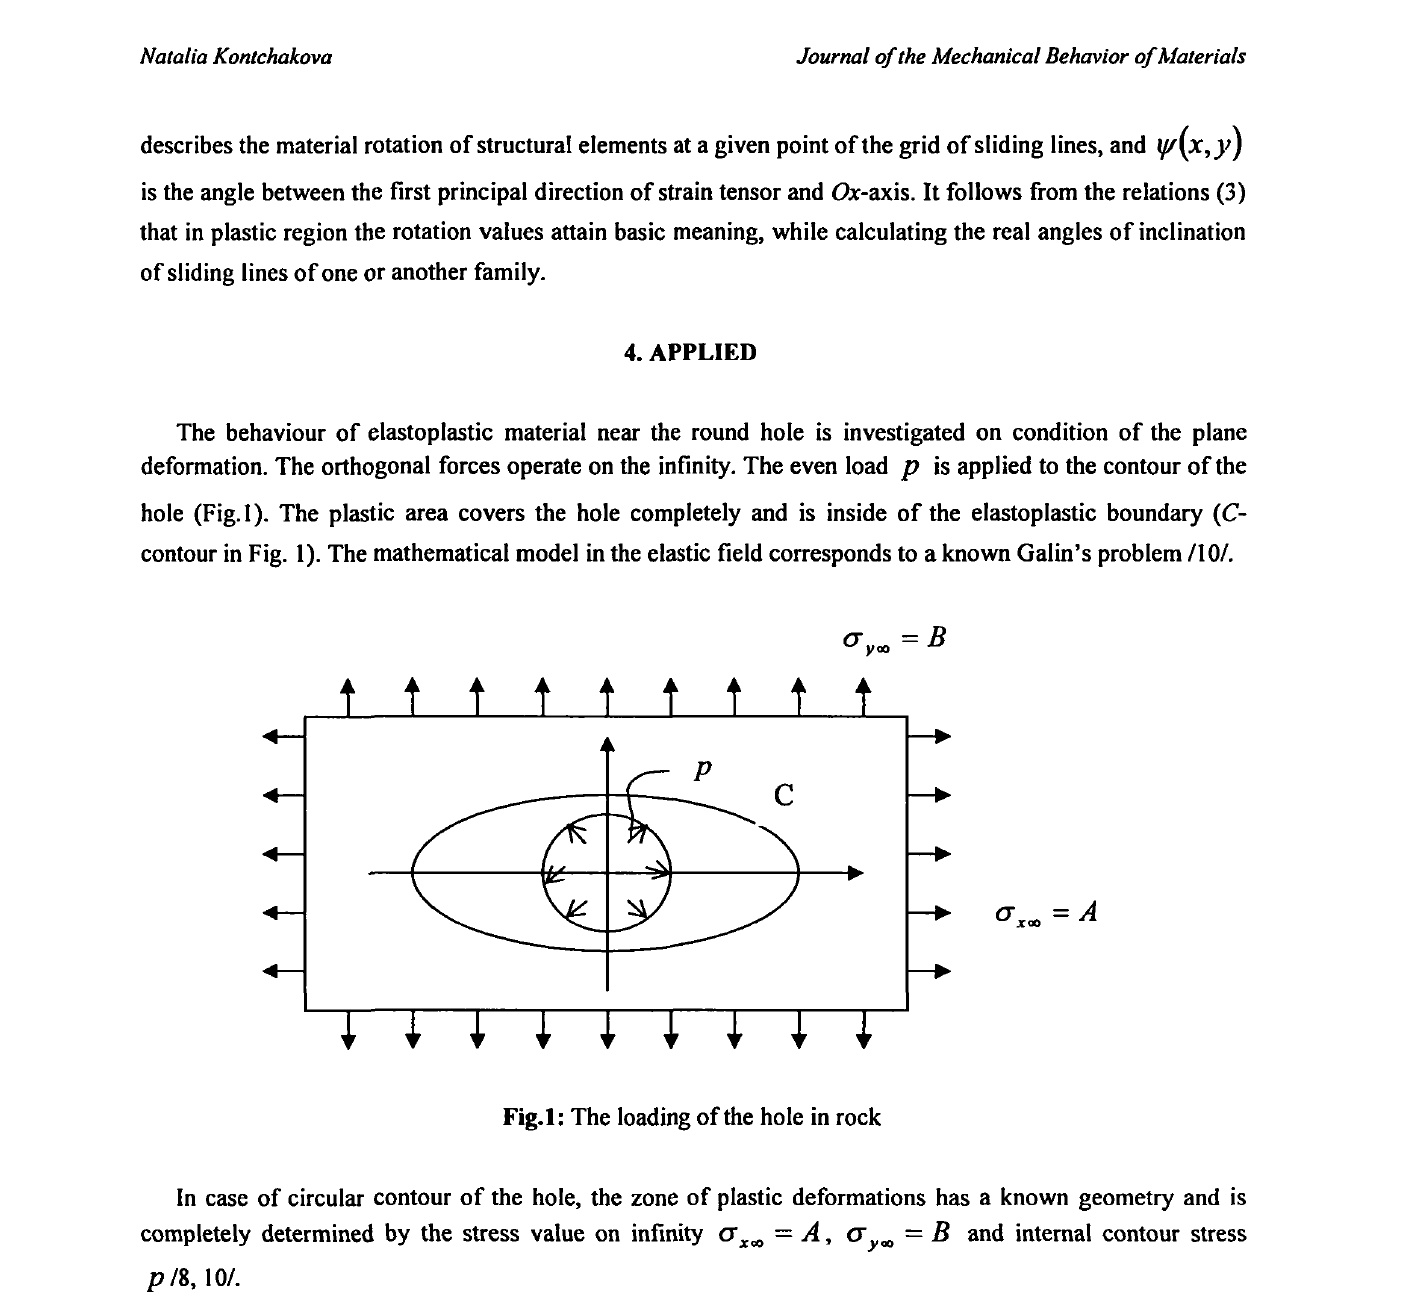
Fig.l: The loading of the hole in